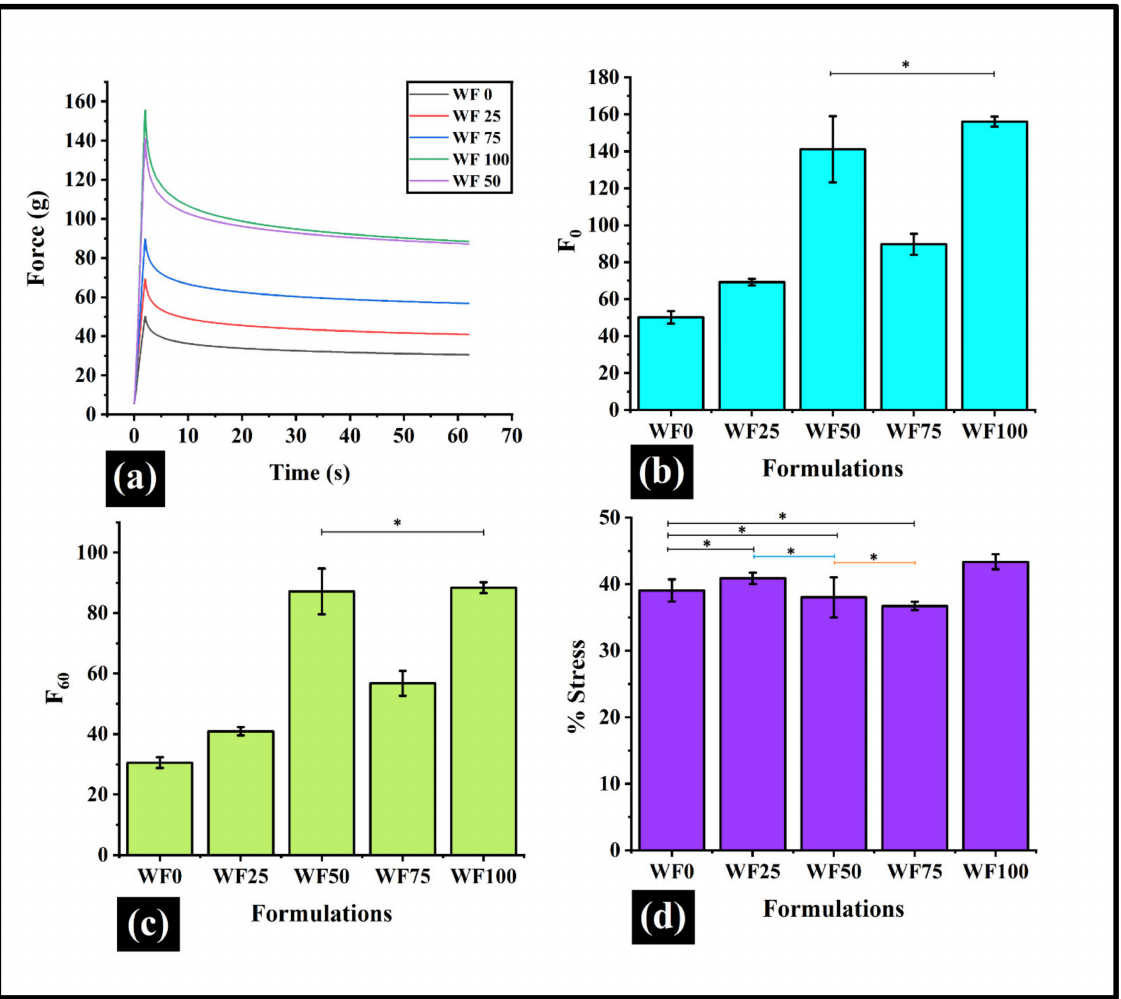
Figure 6. Graphs representing stress relaxation parameters: ( a ) The stress relaxation ( b ) F0; ( c ) F60; ( d ) %SR. The curve is illustrated as a line graph. Data are represented as mean ± SD of triplicates (Formulations with * sign have similar values; p >